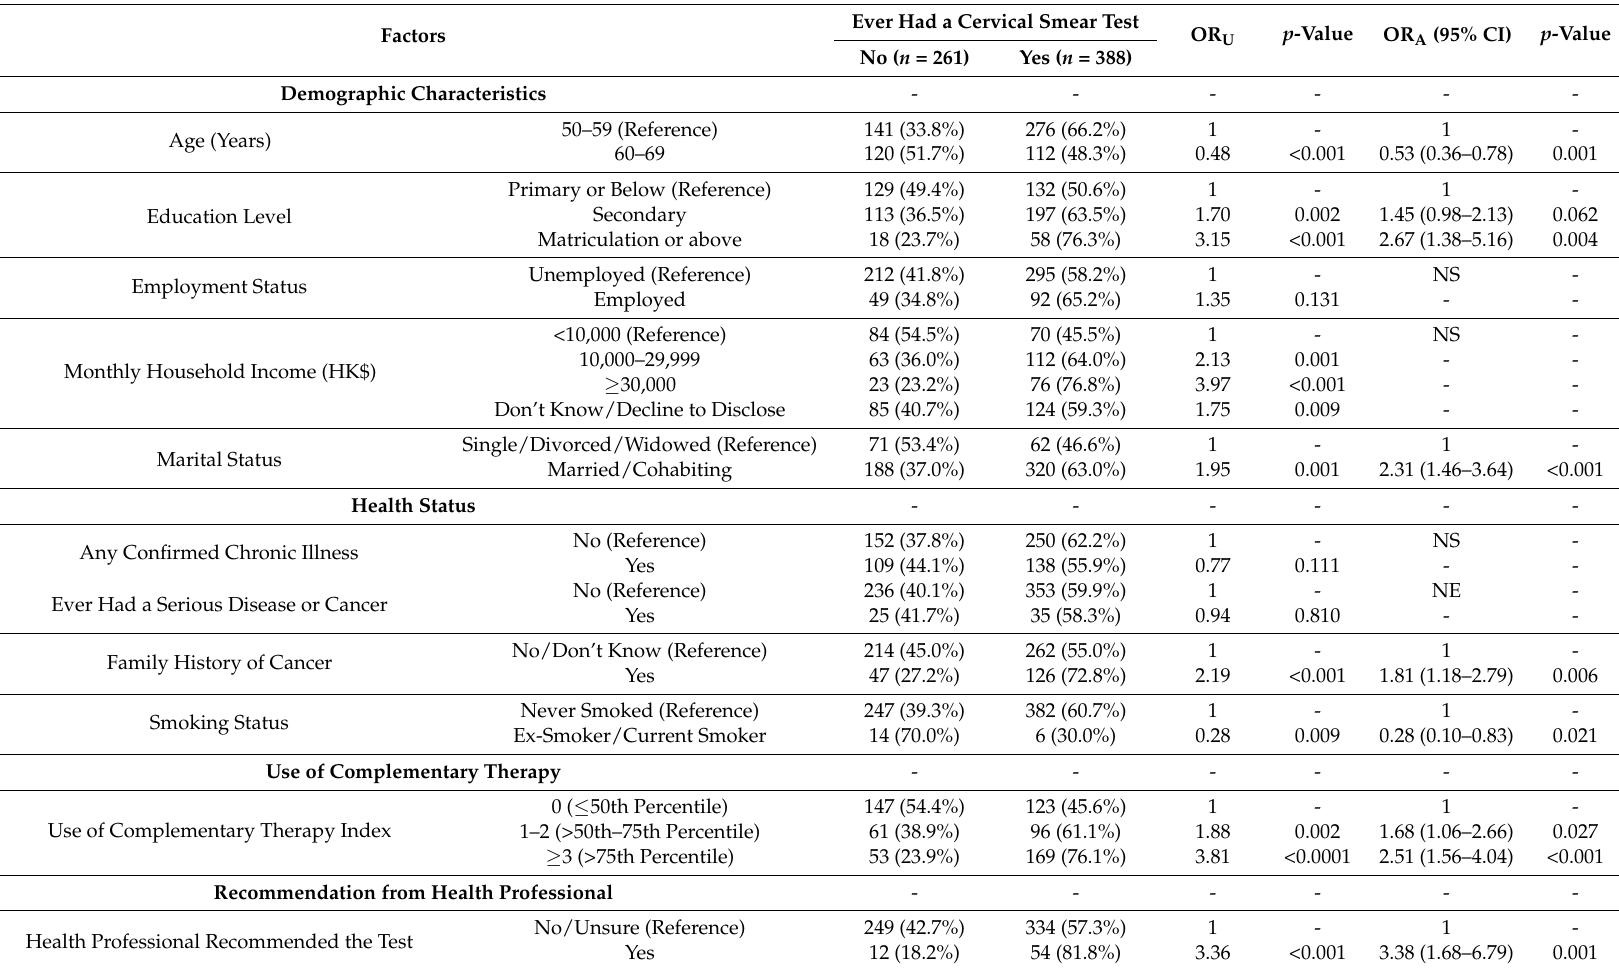
Table 6. Factors associated with women aged 50–69 ever having had a cervical smear